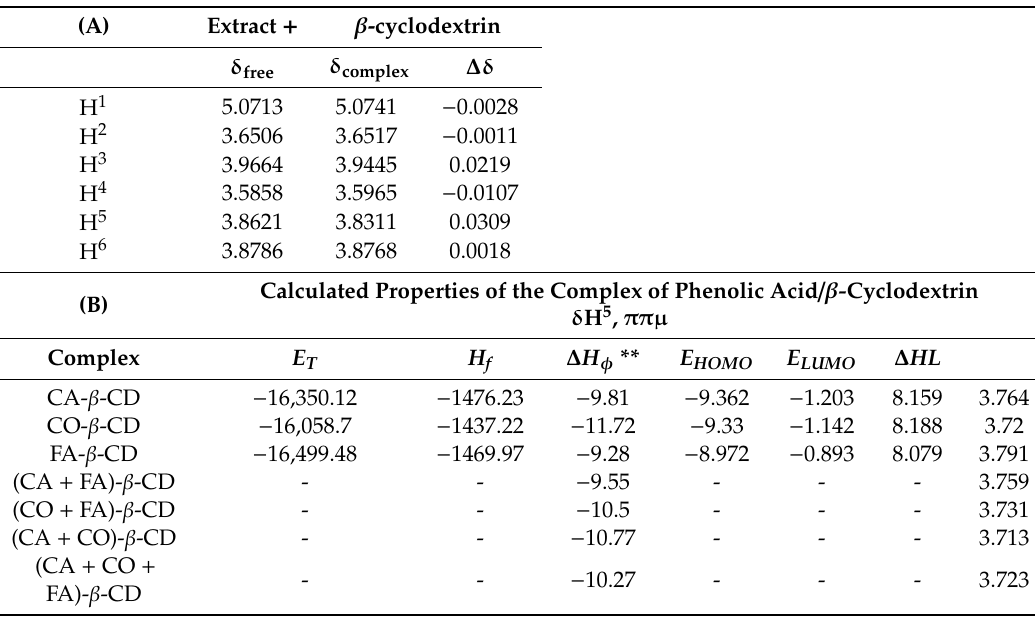
Table 1. 1 H-NMR Chemical shifts ( δ , ppm) for CH protons of β -cyclodextrin pure and their complexation with the wheat bran extract induced shifts (CIS = δ complex − δ guest ) in D 2 O at 25 ◦ C (A) * and experimental chemicalshiftvalues( δ , H 5 )andcalculatedvaluesoftheenthalpyofformation( H f ), ∆ H ,totalenergy( E T